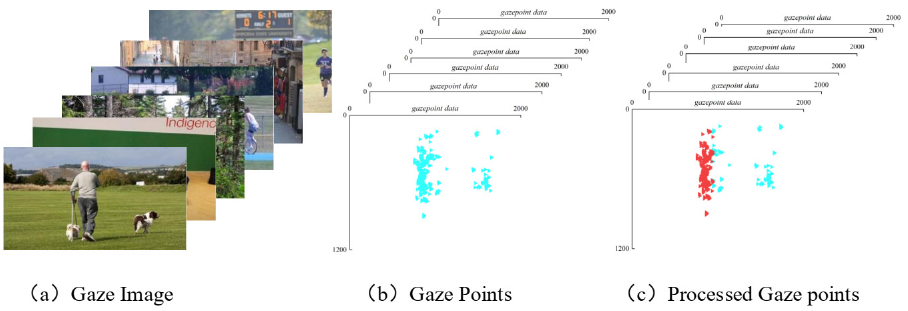
Figure 10. The classification process of gaze point classification. ( a ) the gaze images; ( b ) the gaze points corresponding to each image; ( c ) the gaze point classification results.